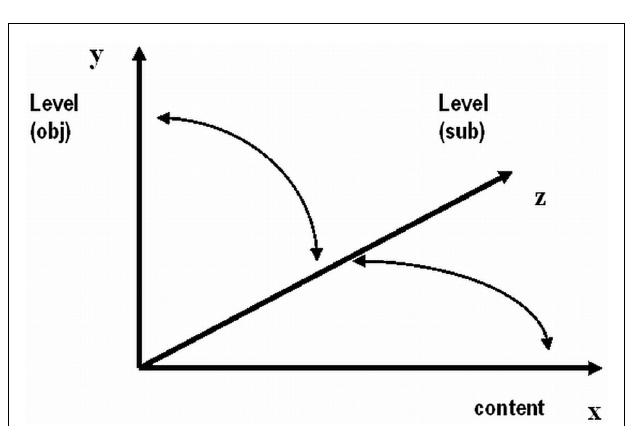
FIGURE 2 | Main correspondences between objective measures of level of consciousness ( y ), subjective measures of level of consciousness ( z ) and measures of content ( x ). (The projection y – x is omitted for parsimony, but it is potentially relevant as